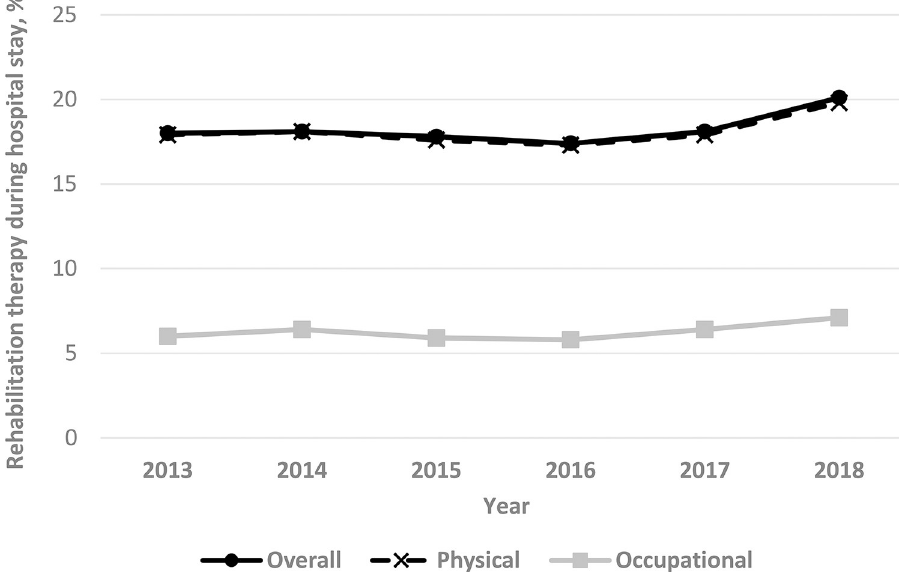
Fig 2. Trends in physical therapy/occupational therapy rehabilitation provided to critically ill children in Korean intensive care units over a 5-year period. ICU, intensive care unit. Overall p for trend < 0.01.